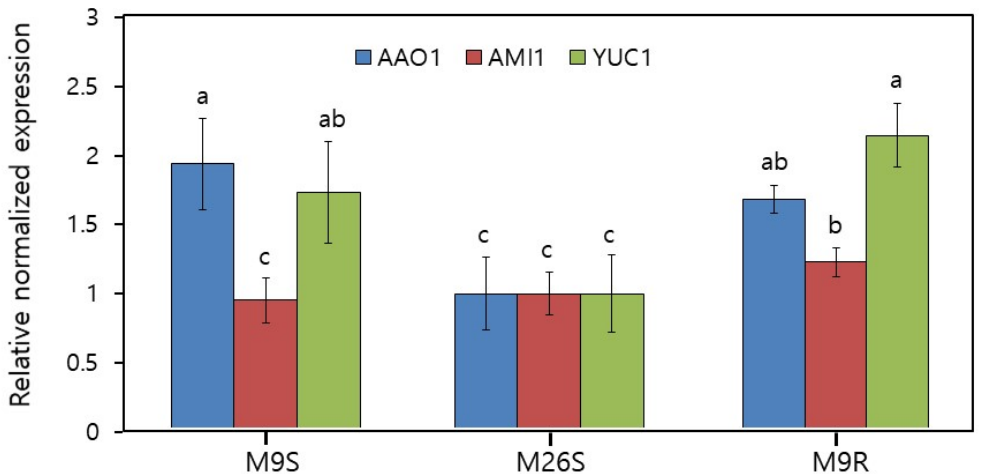
Figure 2. Expression of auxin synthase genes in apple rootstocks M9 and M26 cultured in rooting medium containing IBA 0.1 mg · L − 1 . Gene expression in M9 shoots (M9S), M26 shoots (M26S), and M9 roots (M9R). Indole-3-acetaldehyde oxidase ( AAO1 ), indole-3-acetamide hydrolase ( AMI1 ), and flavin-binding monooxygenase ( YUC1 ). Expression levels were normalized to actin. Error bars represents standard errors (n = 5), and different letters indicate significant differences ( p < 0.05).